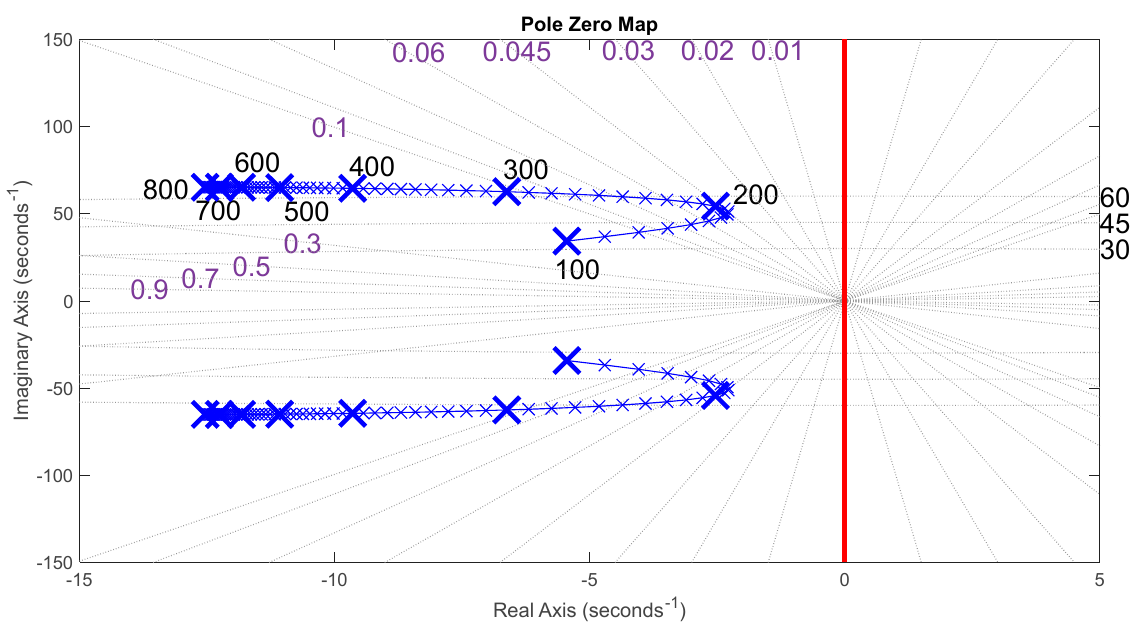
Figure 16. Small-signal model-based root locus analysis for the previous coupled parametric modifications with a bandwidth of 1 Hz for the generator speed control and with coupled modifications of electric and mechanical parameters.